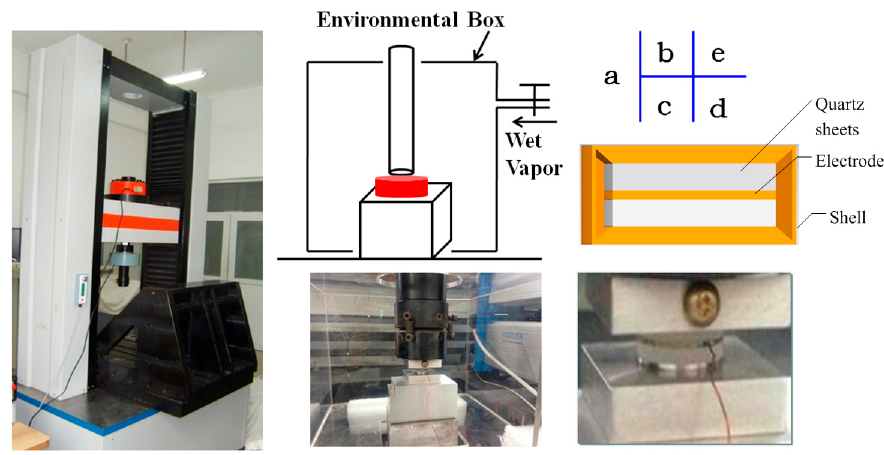
Figure 1. The sketch of the equipment. ( a ) Testing machines; ( b ) An environmental box sketch; ( c ) Charge amplifiers; ( d ) Force-sensitive elements; ( e ) A structure of piezoelectric dynamometers.